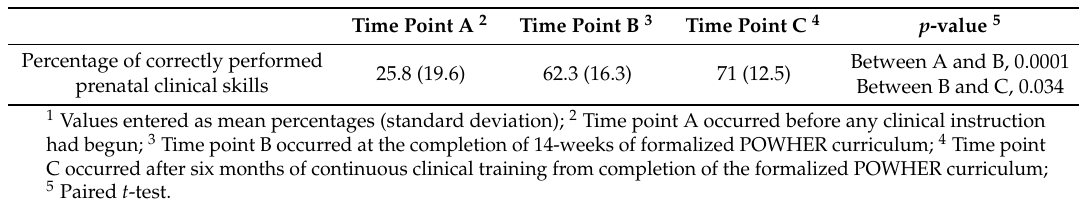
Table 4. The overall improvements in prenatal clinical skills. 1